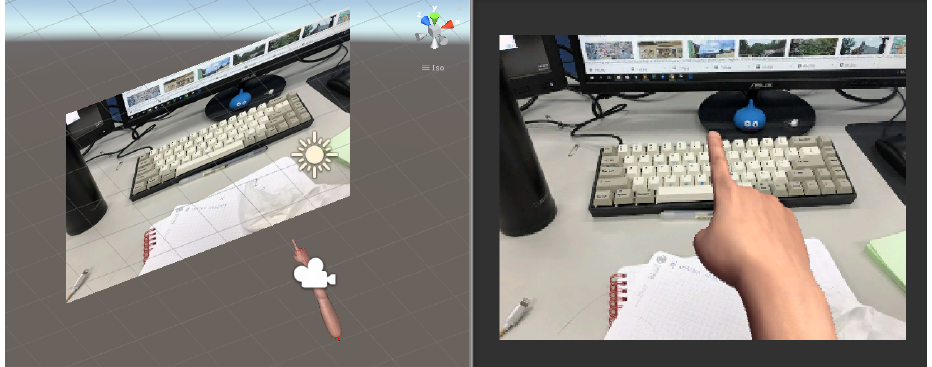
Figure 6. Creation of the egocentric fingertip dataset using